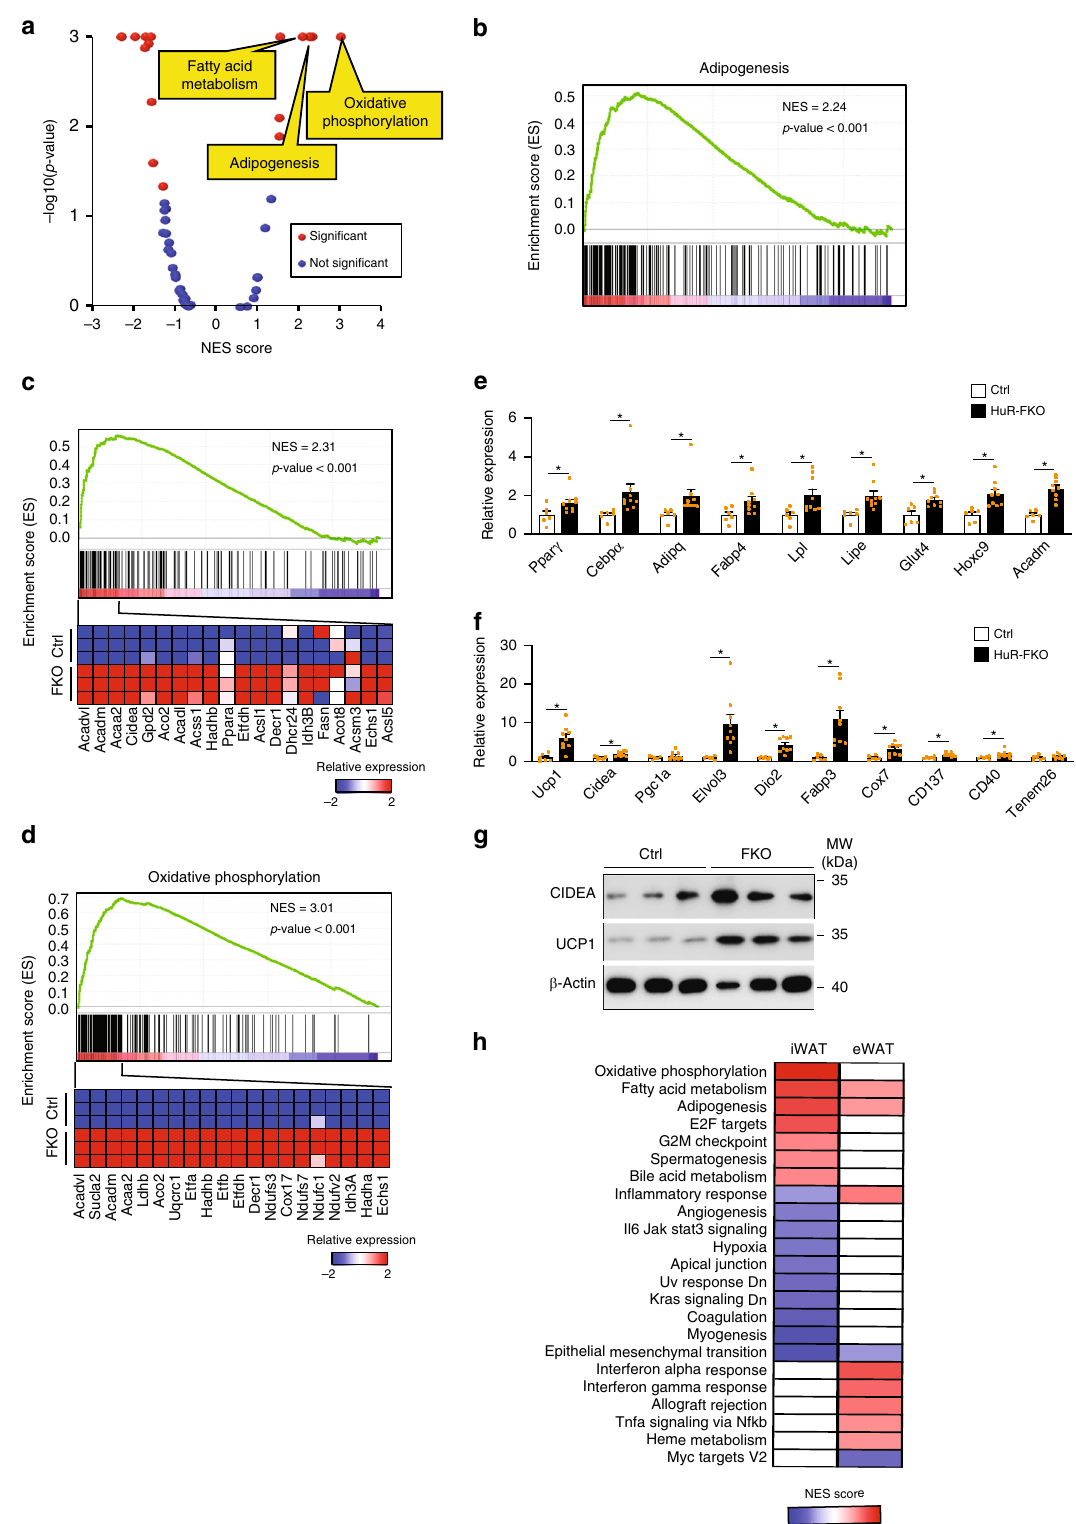
Fig. 4 HuR knockout enhances adipogenesis and browning in iWAT. a GSEA was performed to analyze the pathways affected by HuR depletion in iWAT. Scatterplot depicts the relationship between the p -value and NES score of 50 “ Hallmark ” gene sets in MSigDB. b GSEA on the biological pathway of adipogenesis, c fatty acid metabolism, and d oxidative phosphorylation. e Real-time PCR to con fi rm the expression of genes for adipogenesis, lipogenesis, and f BAT-selective and beige fat markers (Ctrl, n = 6; HuR-FKO, n = 9). g Western blot was performed to examine the protein level of Cidea and Ucp1 in iWAT from HuR-FKO and Ctrl mice. h The regulated pathways in HuR-FKO iWAT and eWAT are displayed in a heatmap. The color represents the NES for each pathway. Error bars are mean ± SEM. Statistical signi fi cance was determined by Student ’ s t -test; * p <